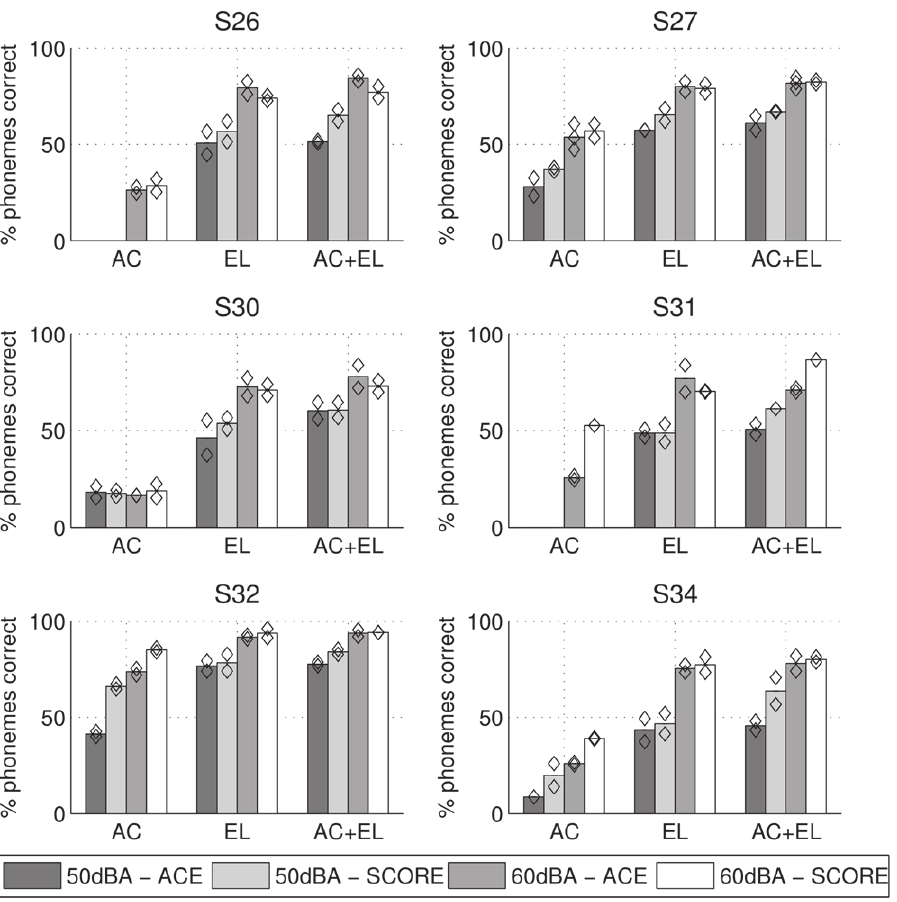
Figure 3. Speech in quiet results for ACE and SCORE, at 50 and 60 dB A presentation level, either acoustic-only ( AC ) , electric-only ( EL ) , or bimodal ( AC + EL ) for each subject. Diamonds indicate results for individual